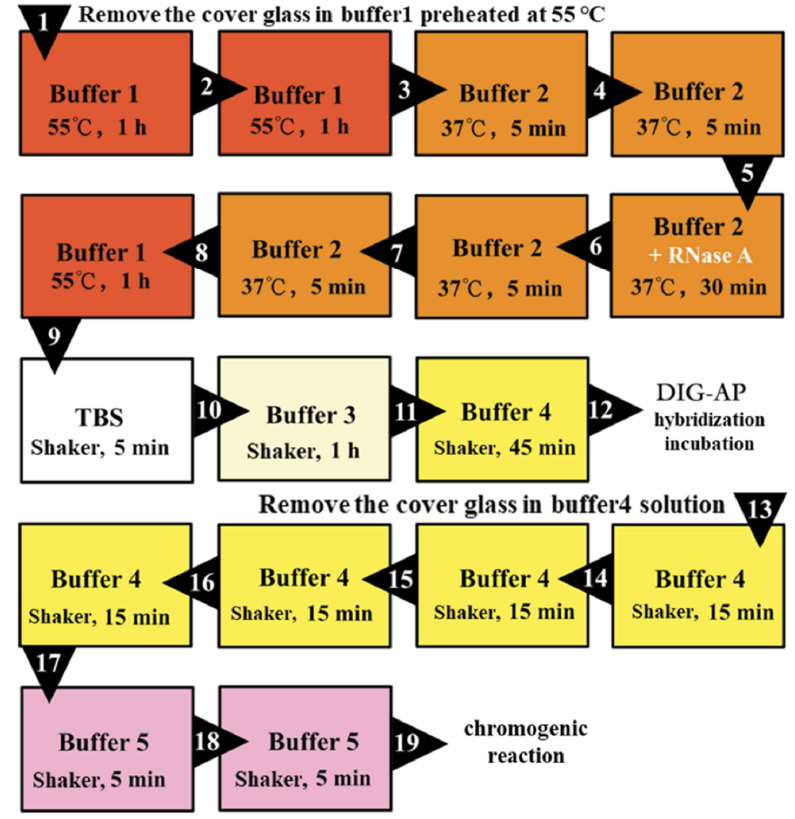
Figure 7. Post-reaction processing diagram of the optimized in situ hybridization.